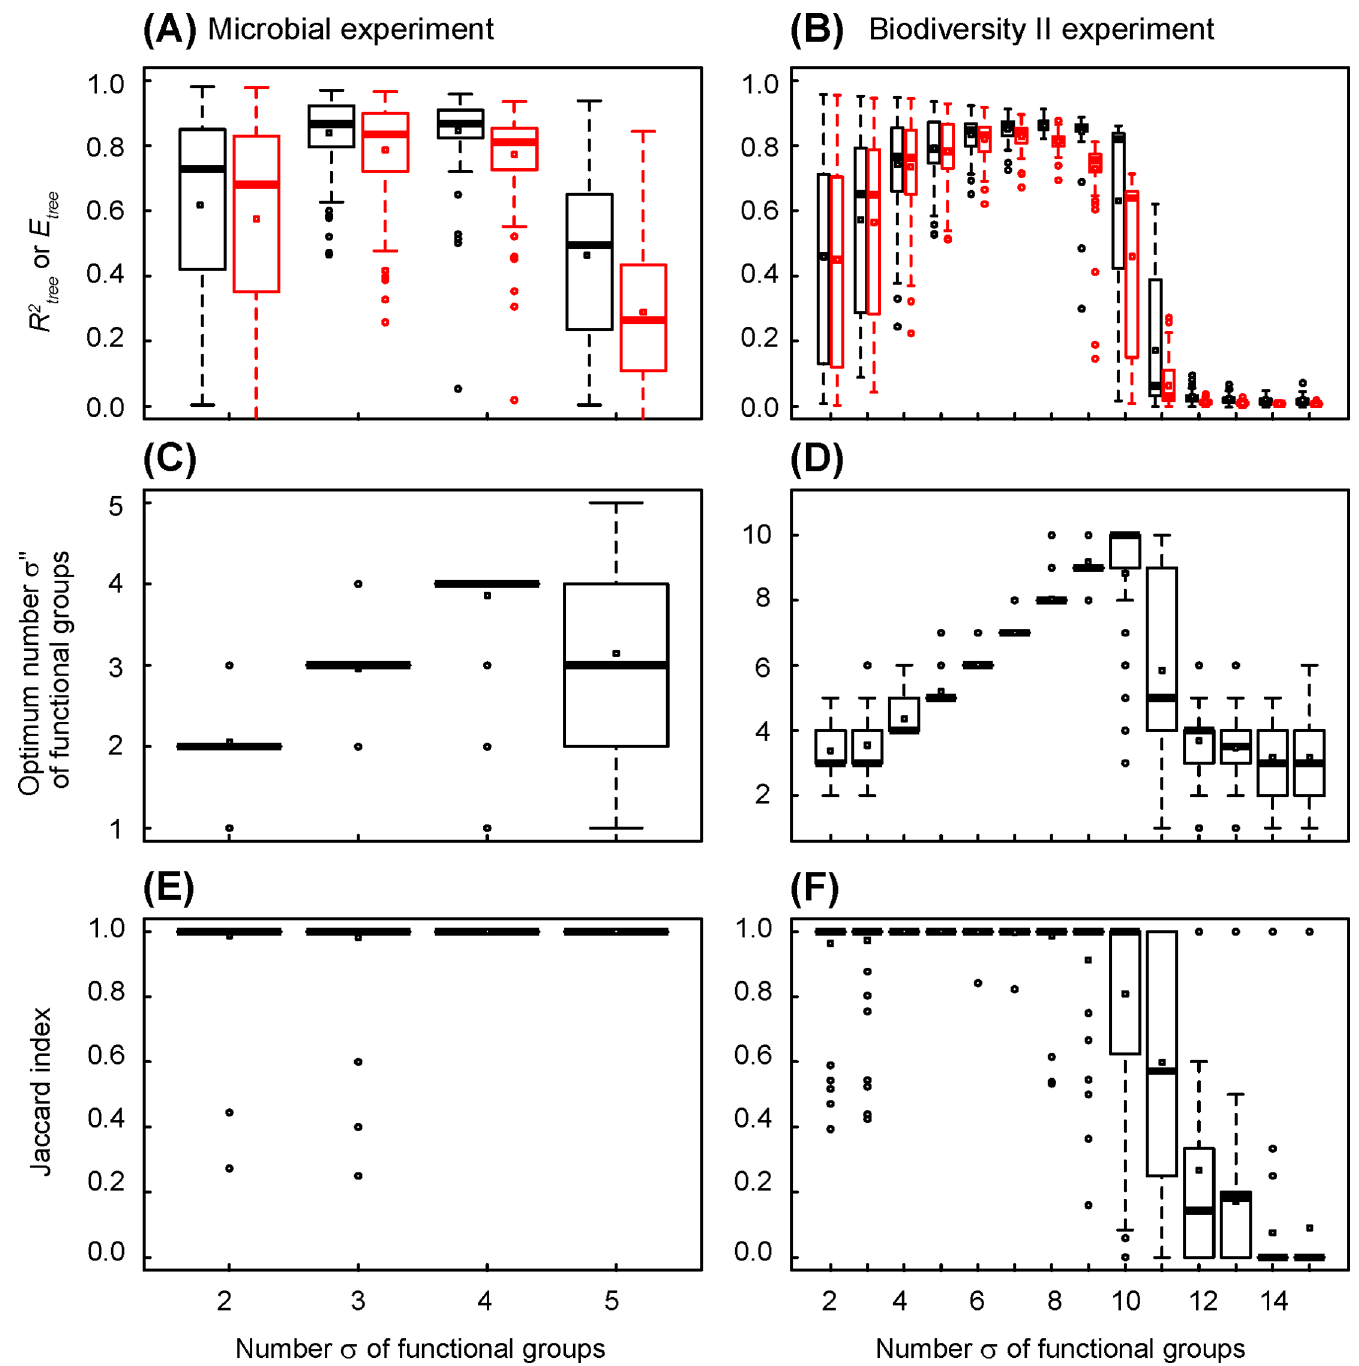
Fig 4. Changes in coefficient of determination, efficiency, optimum number of functional groups and Jaccard index in simulated datasets, versus the number of functional groups of functional structure of ecosystems. The functional structures of ecosystems are those determined by combinatorial analysis of observed datasets (see Fig 2A and 2B), the number of functional groups increasing from the trunk to the leaves of trees. (A), (C) and (E) Simulated dataset mimicking the microbial experiment of Langenheder et al. [16]. All ecosystems are observed and the mean relative error is 0.08. The statistics describe 100 datasets randomly generated. (B), (D) and (F) Simulated dataset mimicking the Biodiversity II experiment of Tilman et al. [17]. The mean relative error is 0.17. The statistics describe 100 random sampling of 2048 ecosystems. (A) and (B) Tree coefficient of determination (in black) and efficiency (in red). (C) and (D) Optimum number of functional groups indicated by tree AICc. (E) and (F) Jaccard